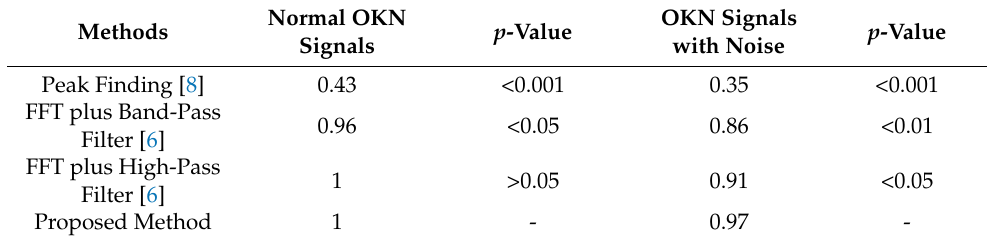
Table 5. Identification rate of each method in identifying OKN signals and OKN signals with